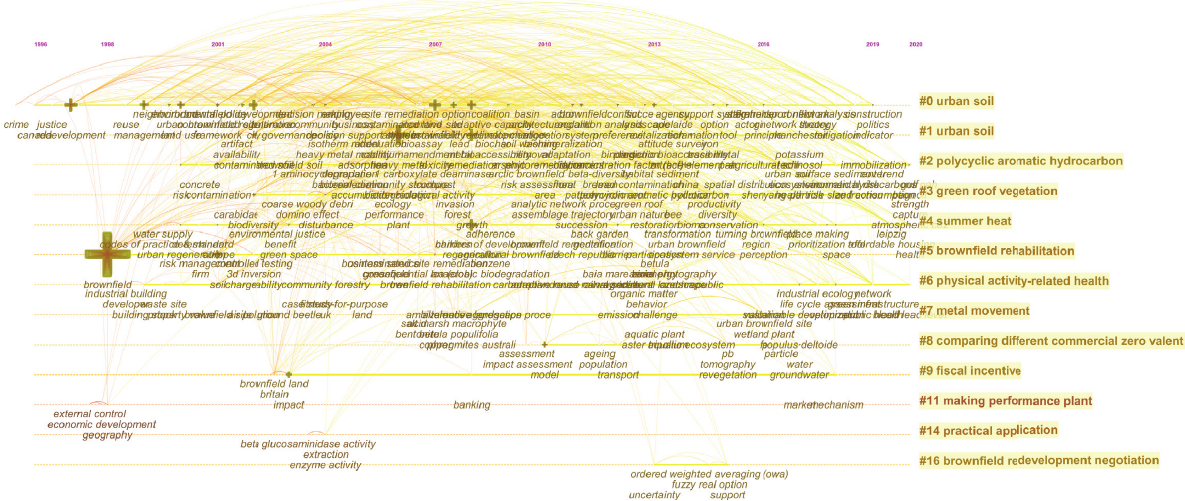
Figure 3: Evolution trends of brownfield research (1998–2020). Table 2: Top 10 most productive authors.